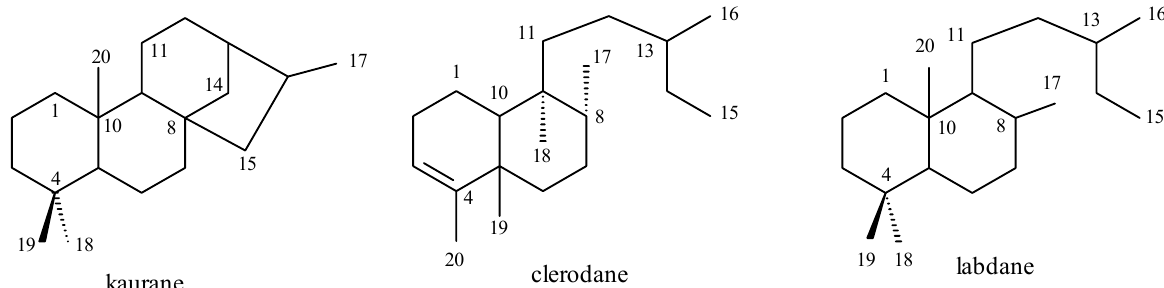
Figure 1 . Diterpene classes present in Aristolochia